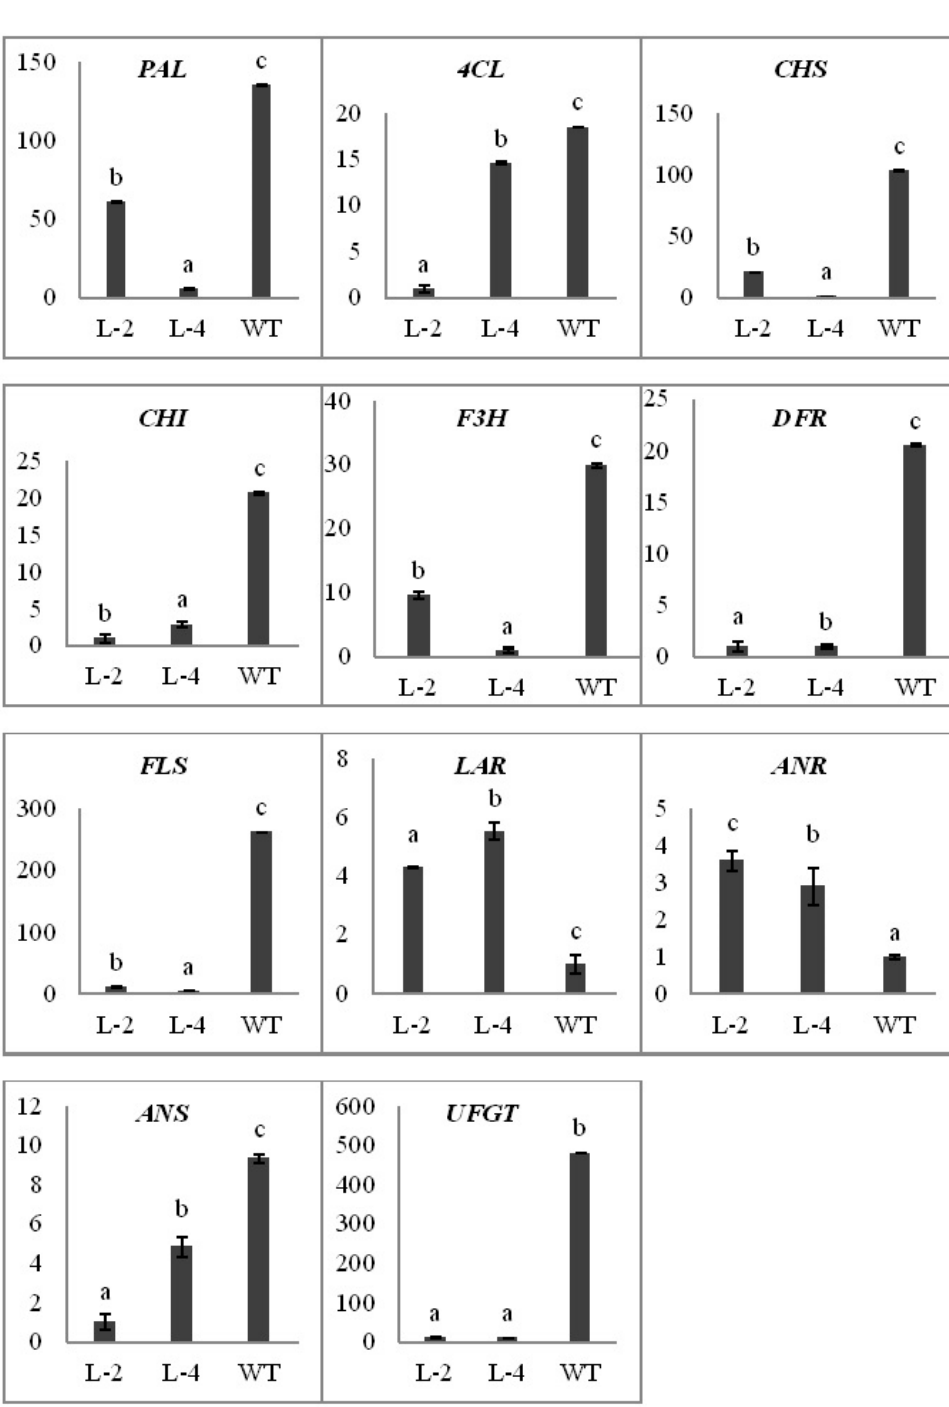
Figure 6. Expression analyses of flavonoid biosynthetic pathway key genes in transgenic flowers carrying NtMYB3 by qPCR. L-2, L-4, indicated two transgenic tobacco lines. PAL, Phenylalanine ammonia lyase; 4CL, 4-coumaroyl-CoA ligase, CHS, Chalcone synthase; CHI, Chalcone isomerase; F3H, Flavanone 3-hydroxylase; DFR, Dihydroflavonol 4-reductase; FLS, flavonol synthase LAR, leucoanthocyanidin reductase; ANR, anthocyanidin reductase; ANS, anthocyanin synthase; UFGT, UDP glucose-flavonoid 3-O glucosyltransferase. Small letter showed the significant difference from wild type at the level of p < 0.05 by using LSD test. The bar represents the standard error of thrice biological replications.